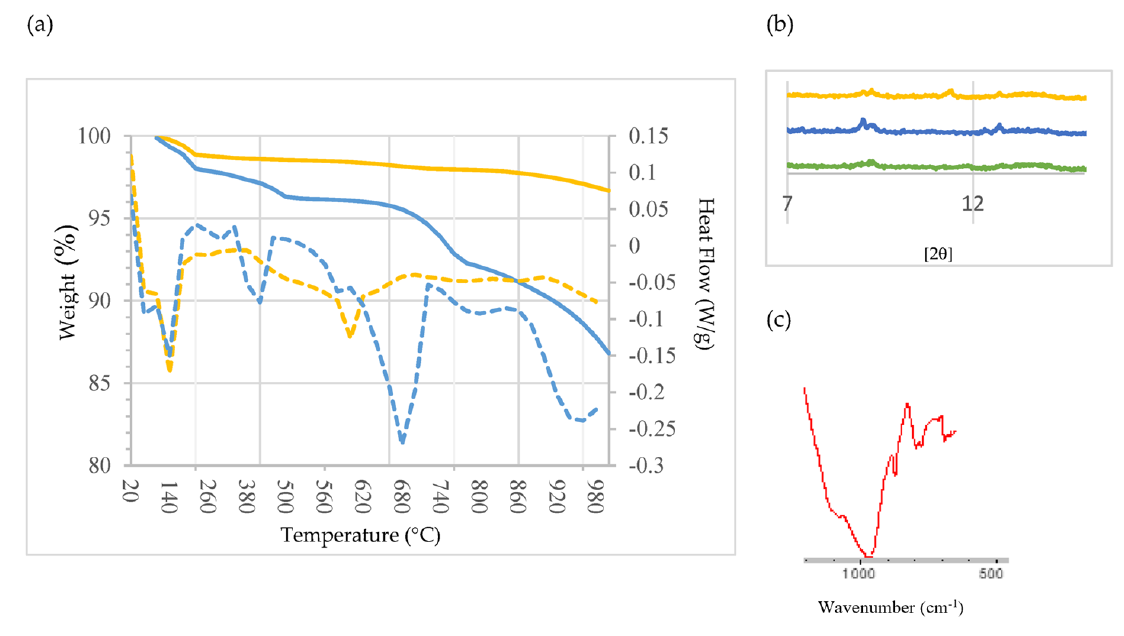
Figure 5. ( a ) TG/DTG analysis of the SCBs: blue: SCB1; yellow: SCB2. Solid line: Weight (%), dotted line: Heat Flow (W/g). ( b ) XRD pattern of CEM III/A (green), SCB1 (blue) and SCB2 (yellow). ( c ) FTIR spectrum of SCB1.